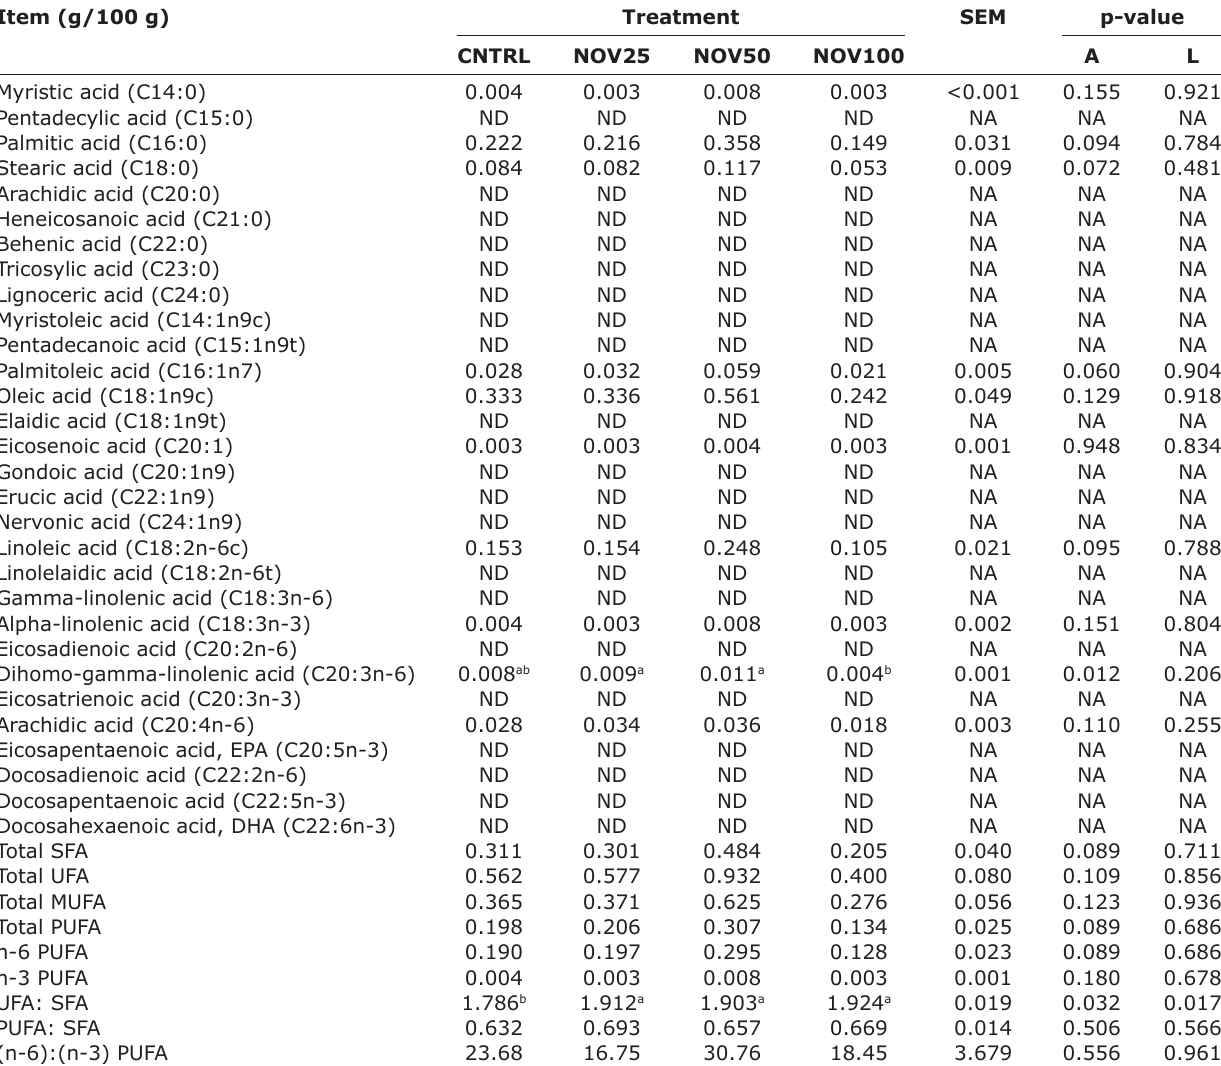
Table-6: Fatty acid profiles of broiler